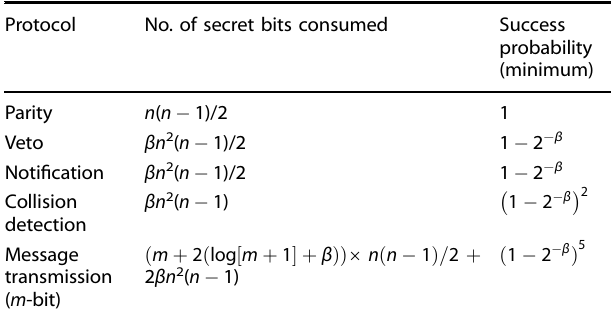
Table 1. The number of secret bits and security parameters of protocols implemented in this paper. Here, n is the number of users and β is mutually agreed upon by all users to achieve a minimum desired success